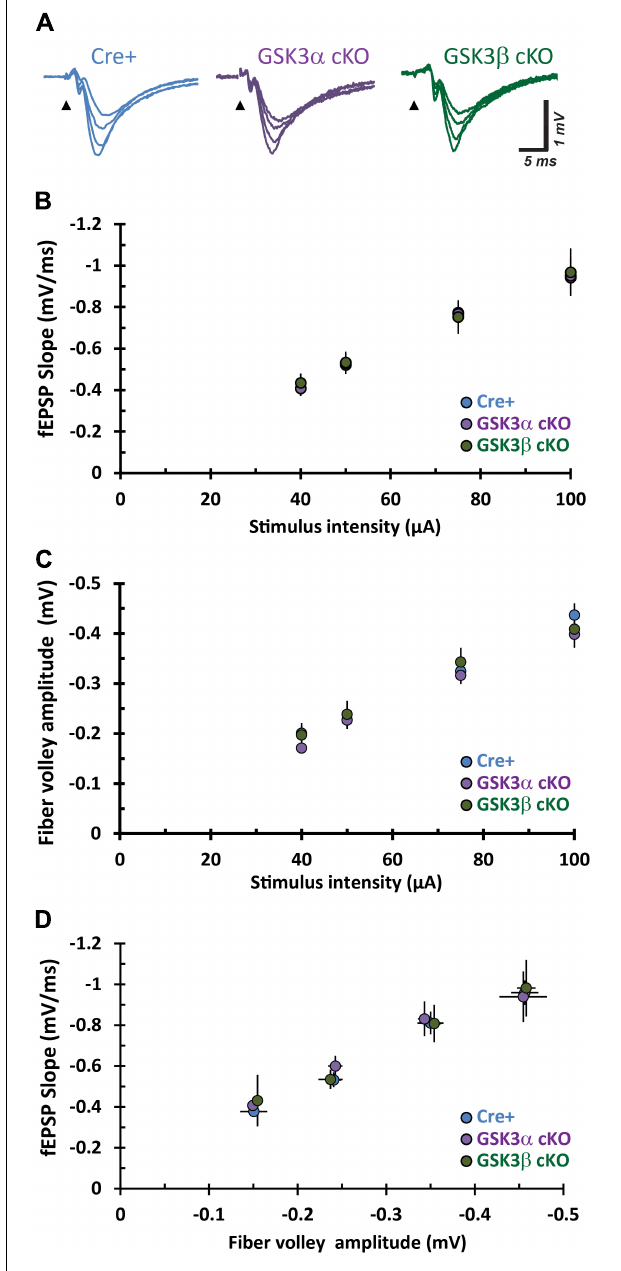
FIGURE 3 | Adult CA3–CA1 basal synaptic function is unaffected by cKO of GSK3 α or GSK3 β . (A) Sample fEPSP traces from hippocampal CA1 slices evoked by test pulse stimulation of Schaffer collaterals at increasing current stimulation (40, 50, 75, and 100 µ A all superimposed). (B–D) Input – output function of synaptic transmission evaluated in three different pairwise comparisons for stimulus current intensity, fEPSP slope, and fiber volley amplitude. The repetitions for Cre-positive (Cre+), GSK3 α and GSK3 β cKO are n = 7, N = 7; n = 12, N = 6; and n = 7, N = 6,